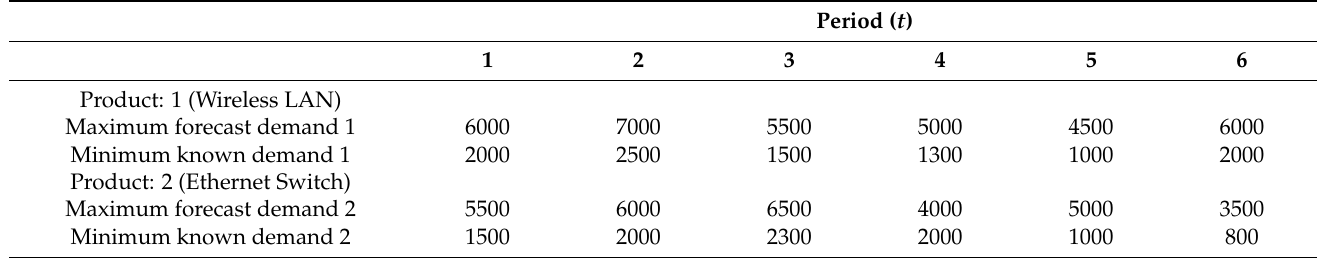
Table 4. Maximum forecast demand and minimum known demand.